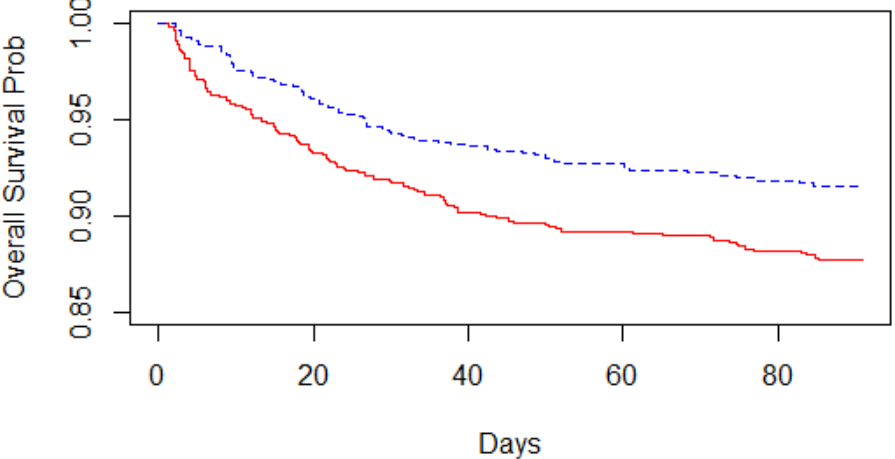
Figure 1. Adjusted Kaplan–Meier graph depicting the risk of CDI recurrence over 90 days. Van- comycin is represented by the solid red line and fidaxomicin by the dashed blue line. The results of the Cox Proportional Hazard model also revealed a statistically significantly decreased risk of CDI recurrence with fidaxomicin in the matched cohort (HR 0.67, 95% CI 0.50 – 0.90).